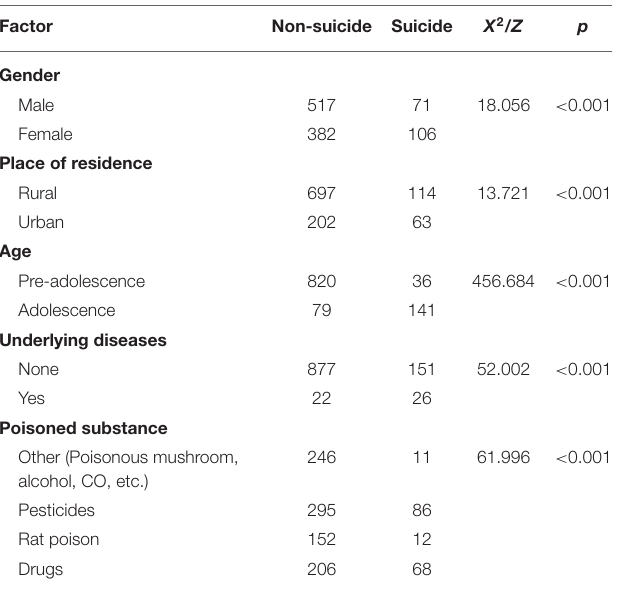
TABLE 4 | Univariate analysis of suicide.